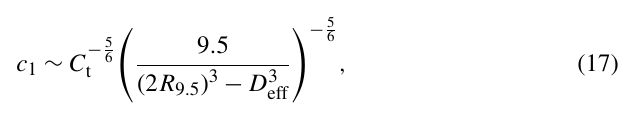
Figure 6. (a) Percentage error, PE, between the Larsen model predictions with or without second-order solution; the color bar indicates incoming-turbulence intensity of the considered lidar cluster. Color maps of the wake velocity field for the lidar cluster with 0 . 85 < U ∗ 0 . 90 and 4% < TI < 5 . 5%: (b) lidar data; (c) and (d) are prediction through the Larsen model without or with, respectively, second-order contribution (green lines are the location of wake edge); (e) and (f) are percentage error with respect to the lidar data without or with, respectively, second-order